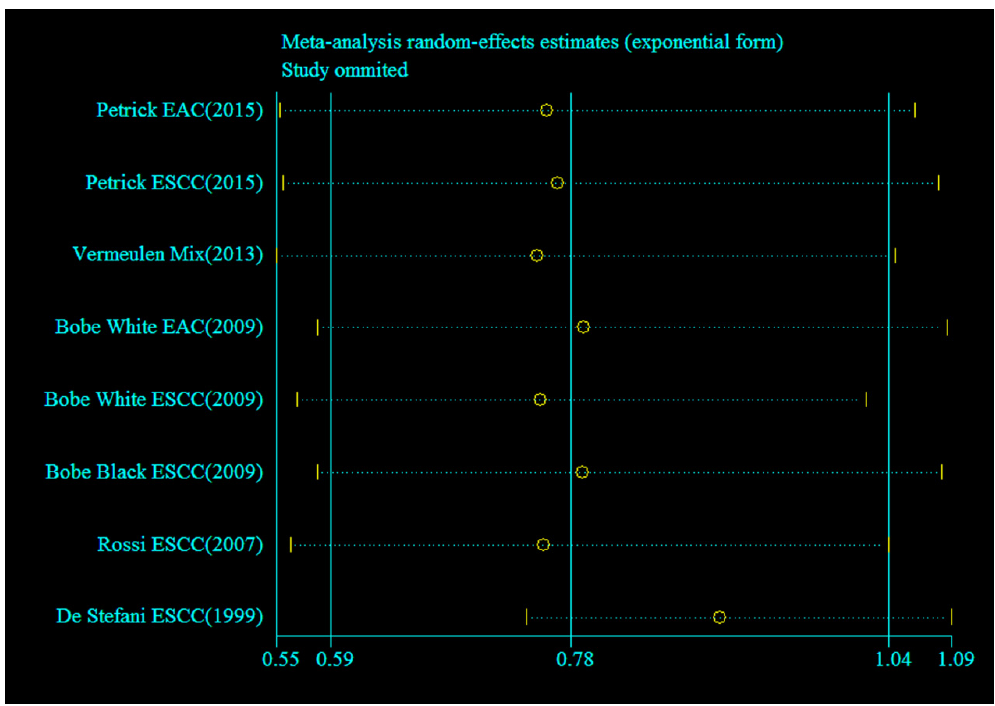
Figure A1. Sensitivity analysis which one study was removed at a time was performed to evaluate the stability of the results.